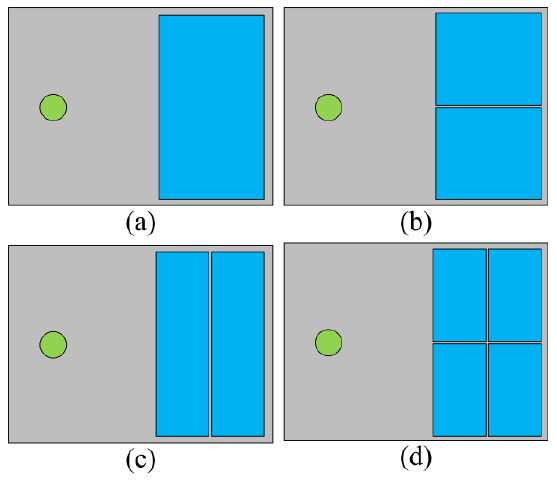
Figure 5. Different icing cases for configuration 2: ( a ) One ice block; ( b ) Two ice blocks separated along X axis; ( c ) Two ice blocks separated along Y axis; ( d ) Four ice blocks.